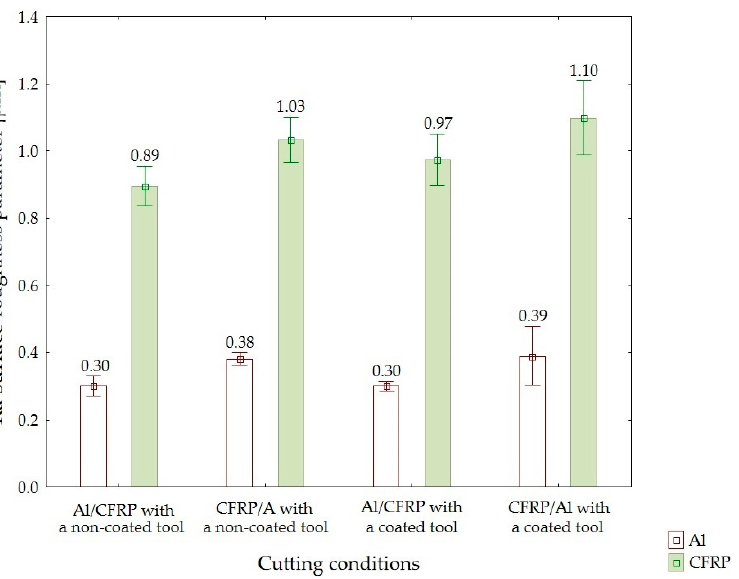
Figure 6. Values of Ra surface roughness parameter depending on the machining configuration and the type of tool.